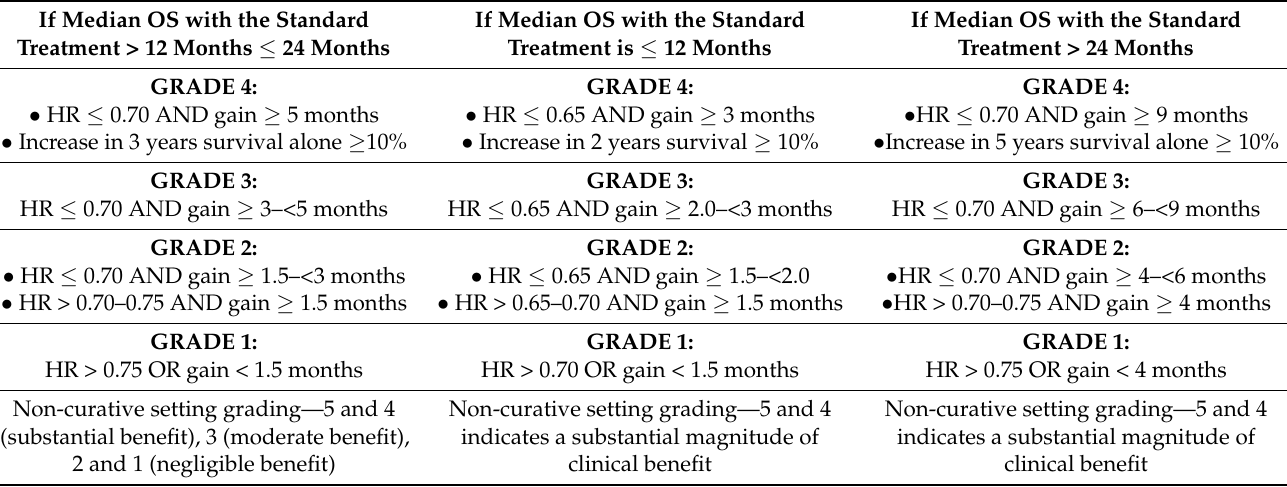
Table 2. ESMO-MCBS v1.1 evaluation form 2A . For therapies that are not likely to be curative with primary endpoint of OS.